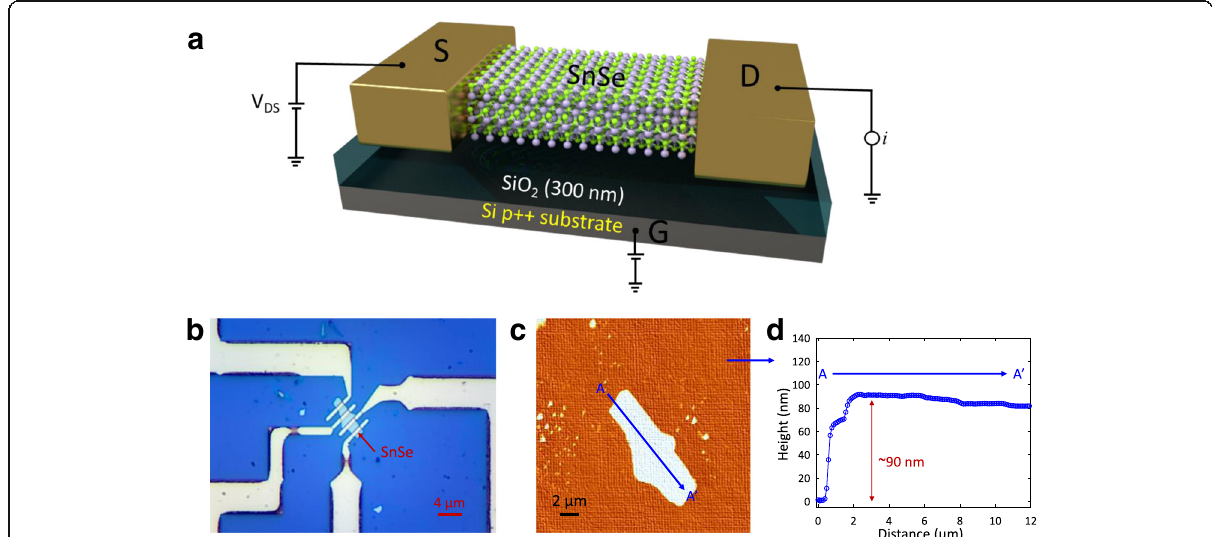
Fig. 3 a Schematic of a mechanically exfoliated SnSe nanoflake FET on a SiO 2 /p ++ Si substrate. b Optical image of a fabricated SnSe nanoflake